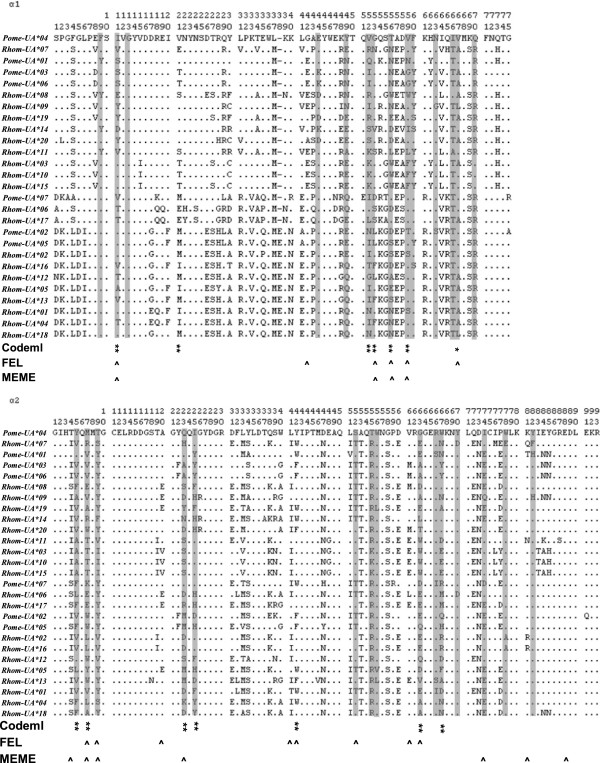
Alignments of partial amino acid sequences translated from the 27 Rhacophoridae MHC class I alleles. Dots indicate identity to Pome-UA*04 and signs “-” denote deletions. Sites in shaded columns represent the putative ABS deduced from structural information for human HLA molecules [47,48]. Signs “*”, “**” refer to amino acids predicted to be under positive selection in the M8 model of PAML, with a posterior probability >95% and >99%, respectively. Signs “^” refer to positively selected sites identified by FEL and MEME.